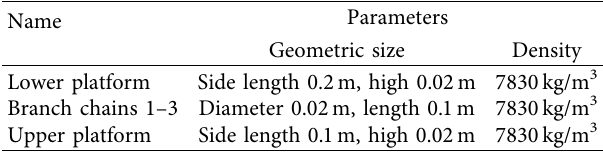
Table 1: Structural parameters of the parallel vibration isolation device.